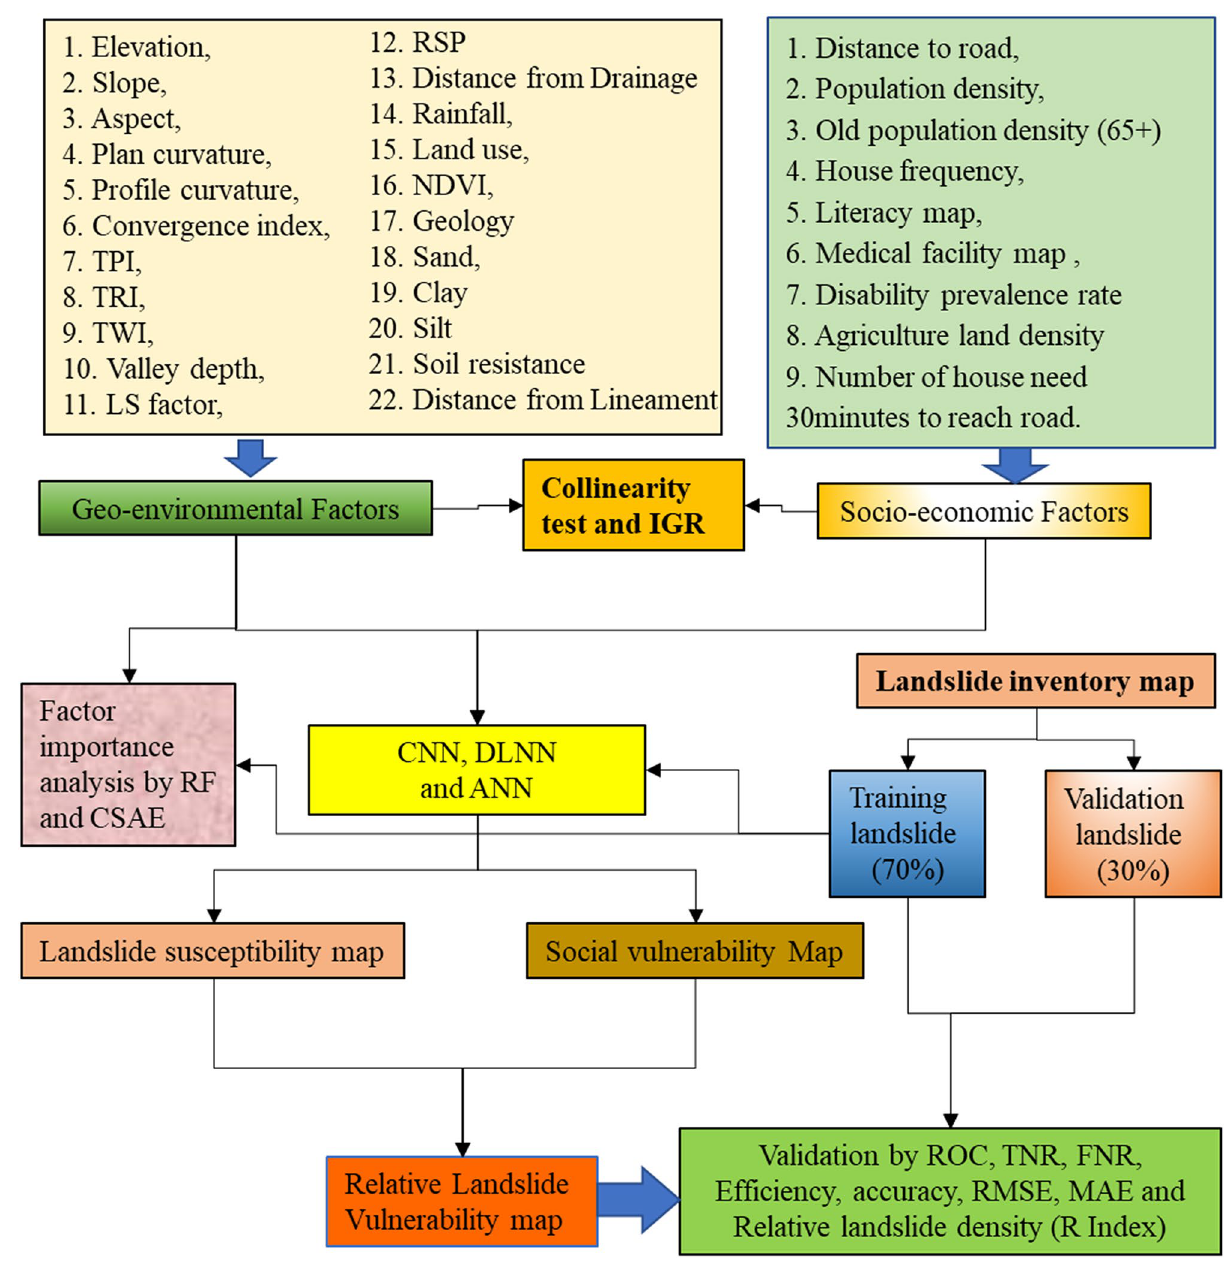
Figure 2. Flowchart of the developed